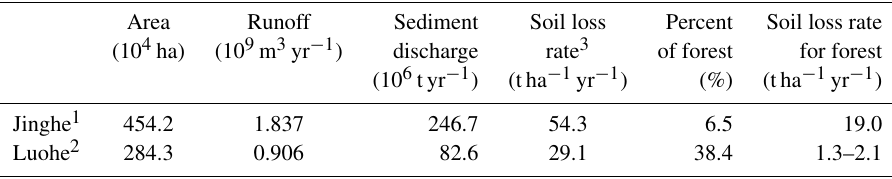
Table 5. Soil erosion rate for the forest and sediment discharge for two